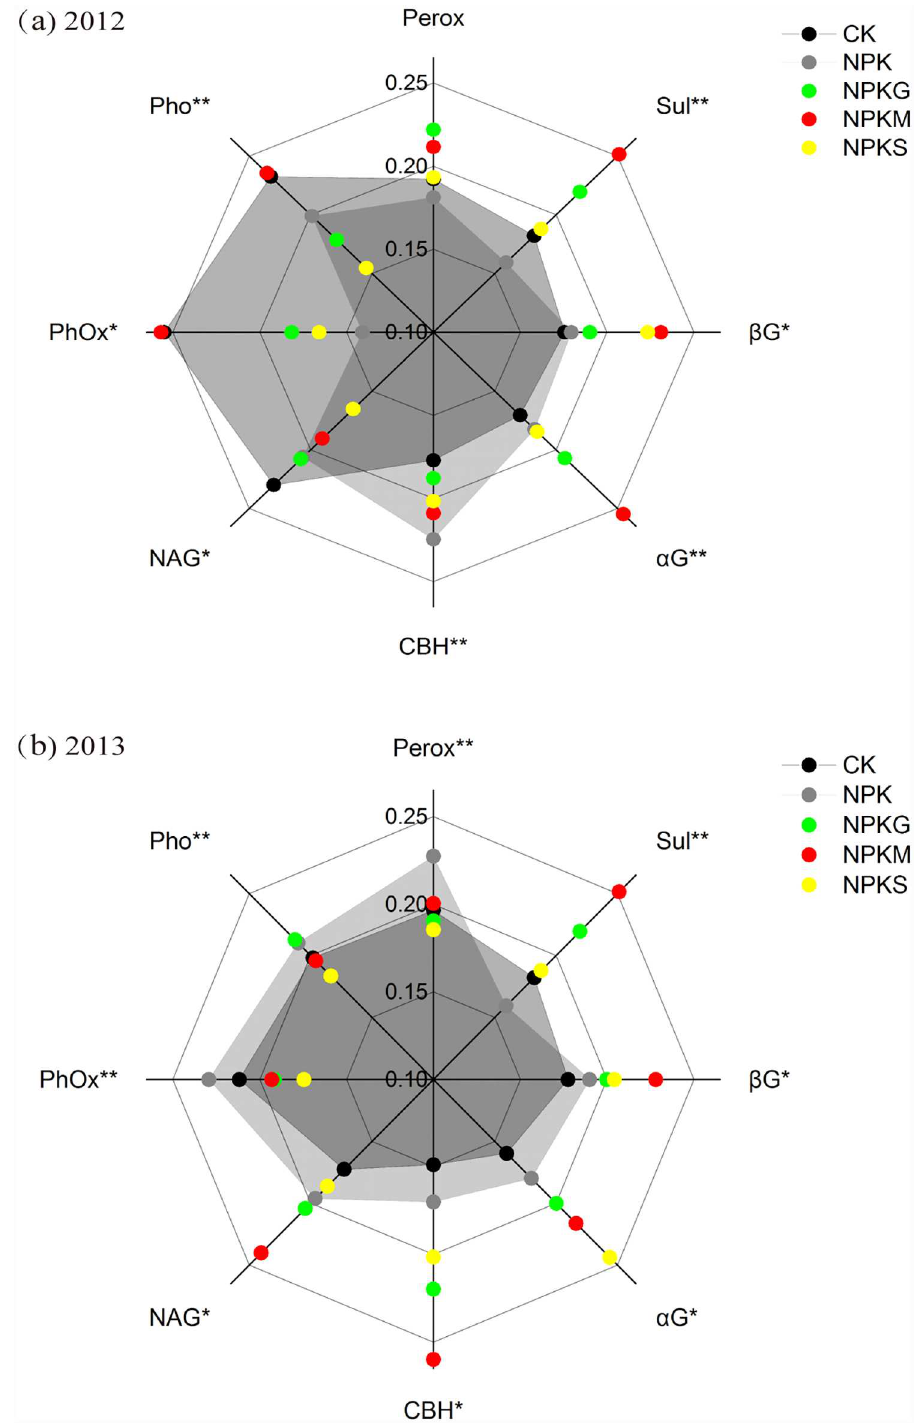
Fig 3. Radar graphs illustrating the relative responses of enzyme activity to different fertilizations in 2012 and 2013. To make a clear comparison when characterizing the organic amendments, the CK and NPK treatments were shown in two shadings. * and ** indicate significant differences between fertilizations at P < 0.05 and P < 0.01, respectively. Abbreviations: α G , α -glucosidase; β G , β -glucosidase; CBH , cellobiohydrolase; NAG , N-acetyl-glucosaminidase; Perox , peroxidase; Pho , phosphomonoesterase; PhOx , phenol oxidase; Sul ,